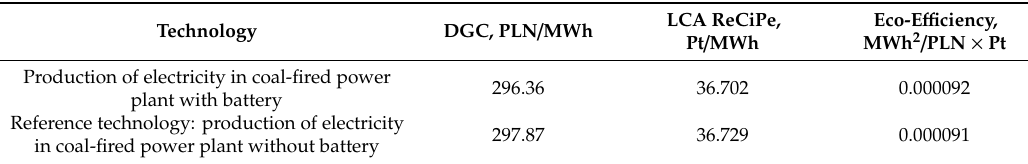
Table 5. The results of the eco-efficiency analysis.